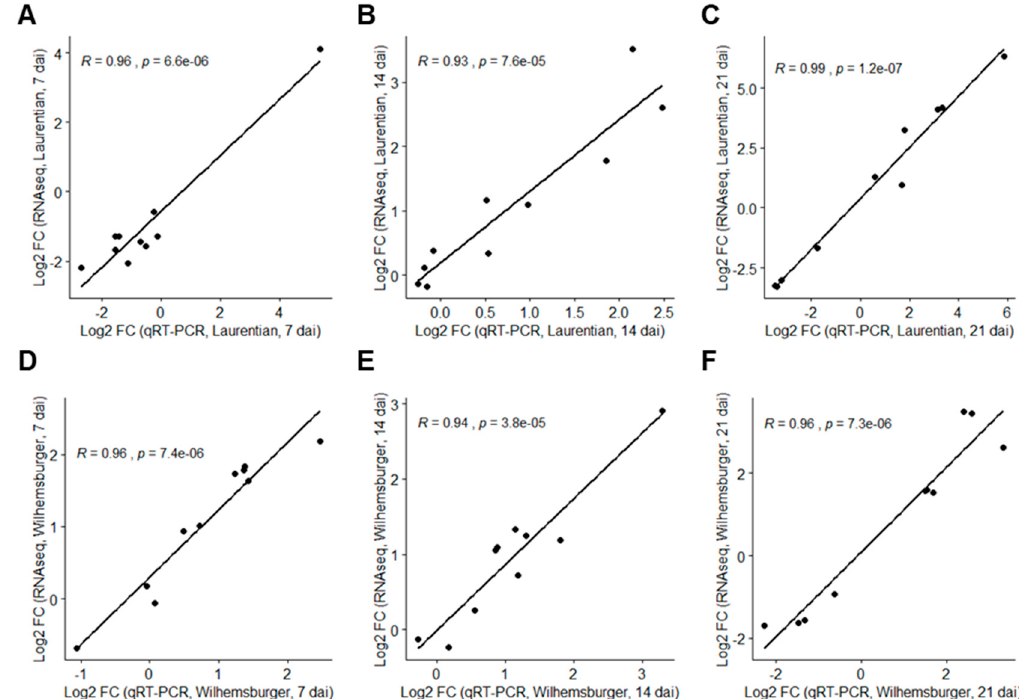
Figure 3. Correlation of log 2 (fold-change) values of 10 selected genes based on RNA-seq and qRT-PCR analyses (inoculated versus non-inoculated). The R values indicate the correlation coefficient between the two methods in each host and time-point, and the p -values indicate the significance level of the t-test. ( A ) ‘Laurentian,’ 7 dai; ( B ) ‘Laurentian,’ 14 dai; ( C ) ‘Laurentian,’ 21 dai; ( D ) ‘Wilhelmsburger,’ 7 dai; ( E ) ‘Wilhelmsburger,’ 14 dai; ( F ) ‘Wilhelmsburger,’ 21 dai.